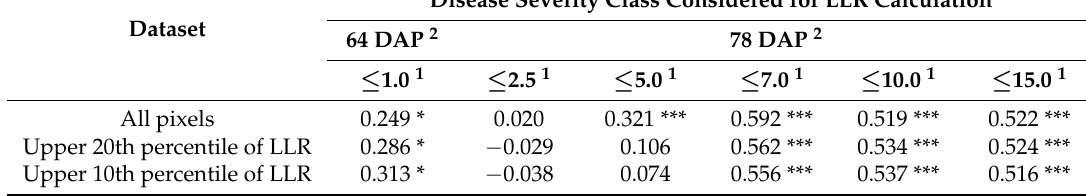
Table 2. Kendall-tau correlation coefficients between disease severity classes (as ordinal variable) and median of log-likelihood ratio (LLR as continuous variable) at sampling unit level for assessment made 64 and 78 DAP. Values are given for each disease severity class used to derive probability distributions, which were compared with the distribution for the reference class (only healthy patches for 64 DAP and ≤ 1.0% severity for 78 DAP) during estimation of pixel-wise LLR. Disease Severity Class Considered for LLR Dataset